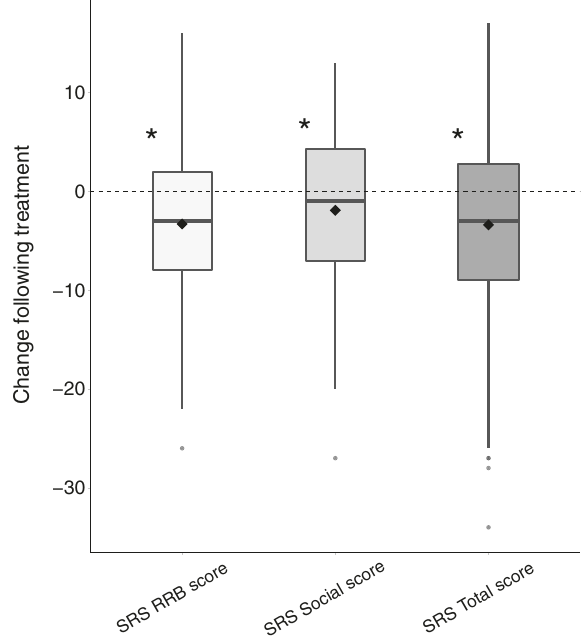
Fig. 3 Change in SRS scores, before and after treatment. SRS restricted and repetitive behaviors (RRB) scale, SRS social scale, SRS total score. Asterisk: Signi fi cant change ( p < 0.05, randomization test). Black diamond: mean. Bold line: median.